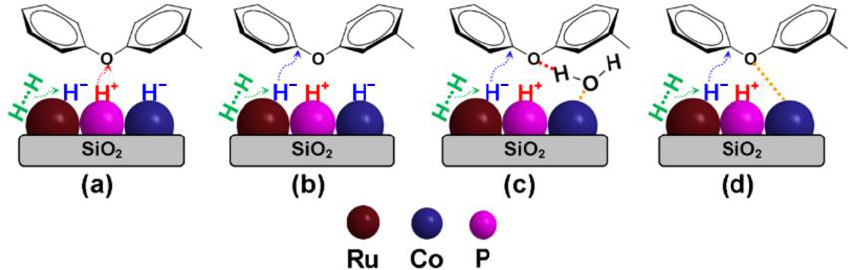
Figure 10. Possible initiation reactions for hydrogenolysis of 3-methyl diphenyl ether over CoRuP/SiO 2 . ( a ) H + attacking oxygen atom; ( b ) H − attacking substituted aromatic carbon atom; ( c ) with water assistance; ( d ) with Lewis site assistance.